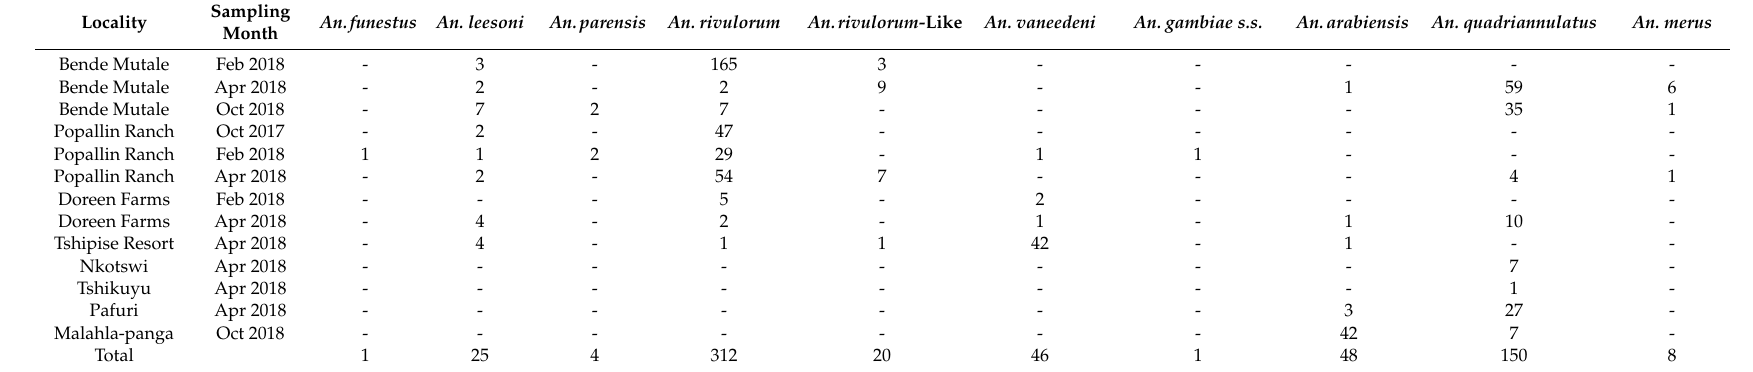
Table 10. Polymerase Chain Reaction-identified Anopheles species collected in the northern Limpopo Province, South Africa.